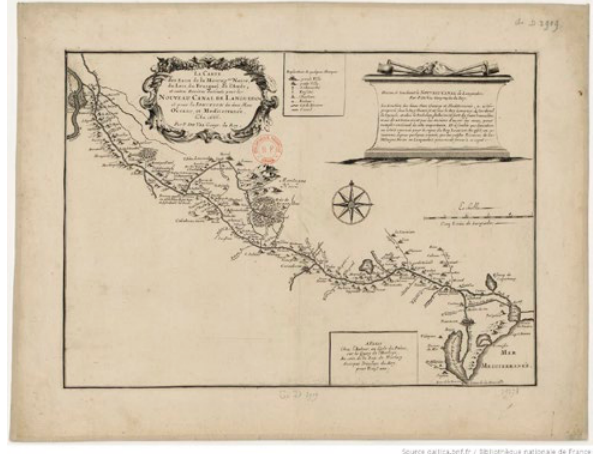
Figure 22. Map of the Nouveau Canal de Languedoc , Paris 1677.